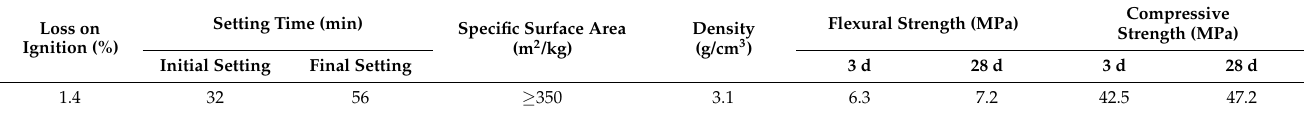
Table 2. The physical properties of